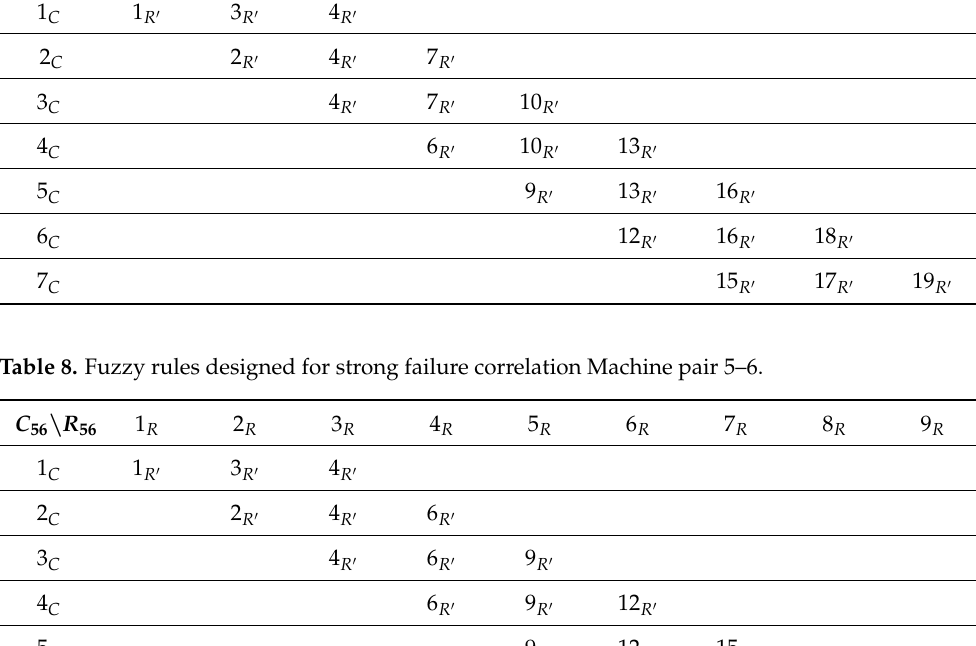
Table 7. Fuzzy rules designed for weak failure correlation Machine pair 5–6. C 56 \ R 56